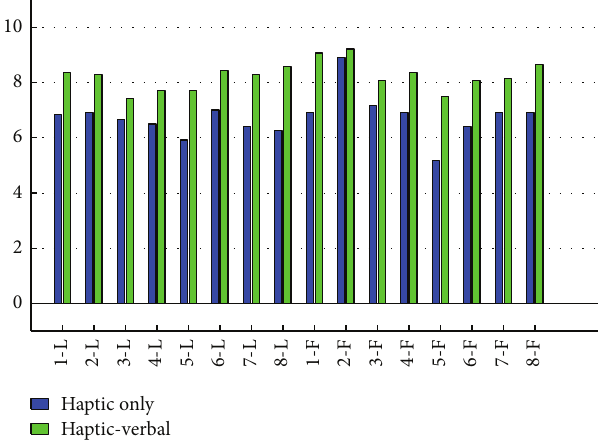
Figure 6: The mean responses of leaders (L) and followers (F) to the 8 questions in the modified NASA Task Load Index (TLX) survey in